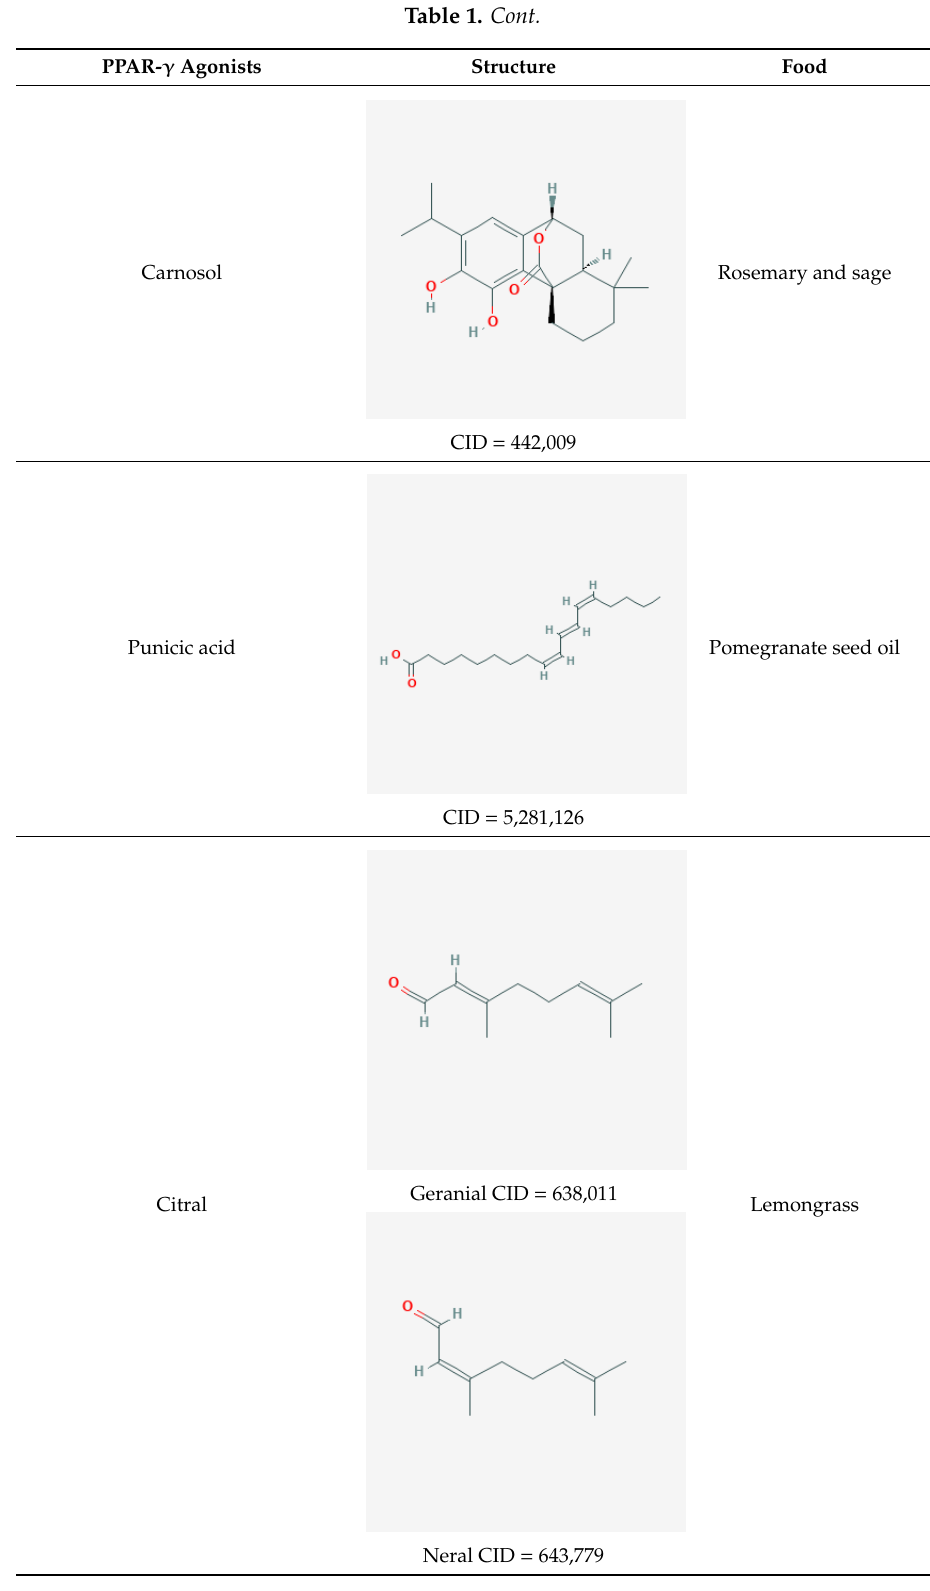
Table 1. Nutritional agonists of PPAR- γ . The table summarizes the main nutrients activator of PPAR- γ and their chemical